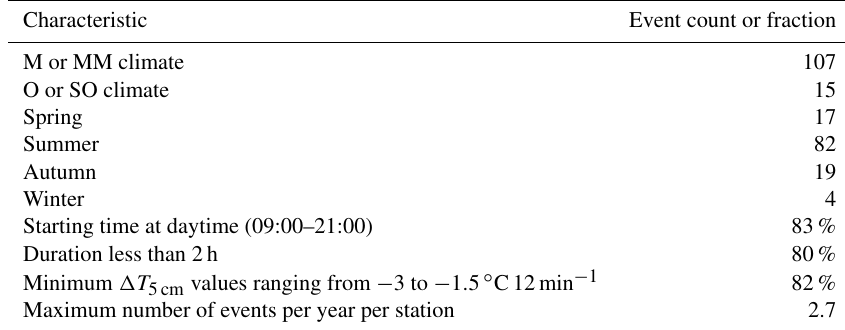
Table 4. Characteristics of the 122 intense soil-cooling rains.